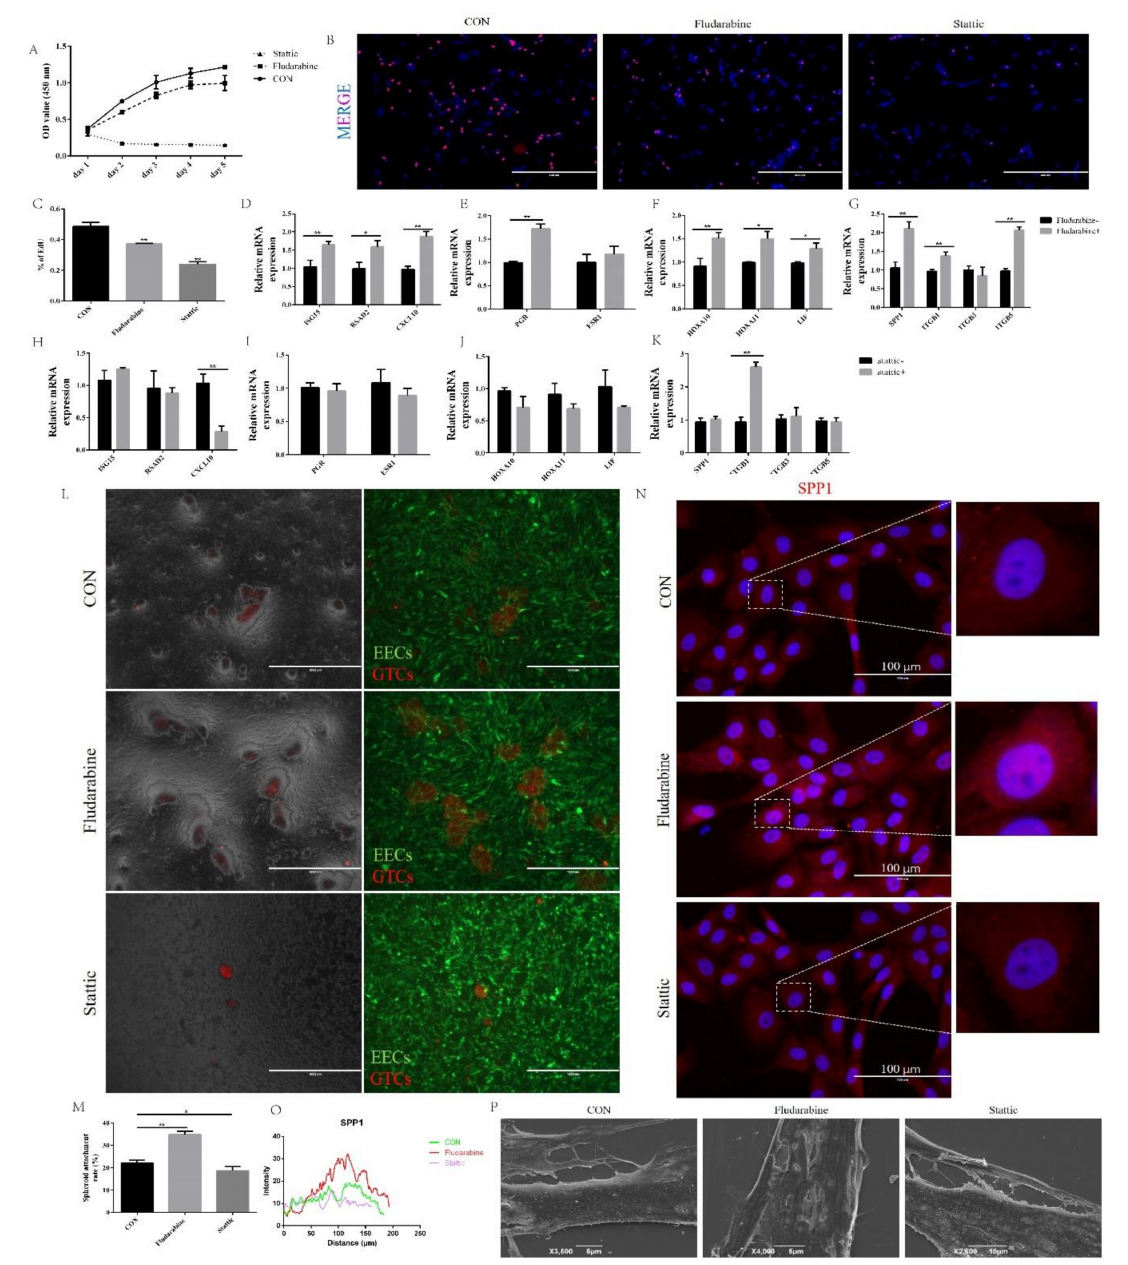
Figure 4. Inhibition of the STAT1 pathway suppressed BCL2L15 silencing-induced endometrial receptivity defects. ( A ) The cell proliferation was measured using a CCK-8 assay. ( B , C ) The DNA synthesis was measured using an EdU proliferation assay ( D – K ) The shBCL2L15 EECs were pretreated with or without fludarabine and Stattic. Then, the EECs were treated with hormones, followed by treatment with IFN- τ for 12 h, and then collected for real-time quantitative PCR. ( L , M ) Fludarabine treatment increased the adhesion of GTCs spheroids on EECs. Scale bar = 1000 µ m. ( N , O ) Fluorescence microscope images of the SPP1 expression in the CON, fludarabine, and Stattic EECs, which were treated with hormones followed by IFN- τ treatment for 6 h. Representative images of three independent experiments are shown. Scale bar = 100 µ m. ( P ) Scanning electron microscopy (SEM) of EECs, which were pretreated with or without fludarabine and Stattic. Then, EECs were treated with hormones followed by treatment with IFN- τ for 12 h. The data are presented as the means ± S.E.M. of three independent experiments. * Significant di ff erence ( p < 0.05) compared with other groups; ** Significant di ff erence ( p < 0.01) compared with other